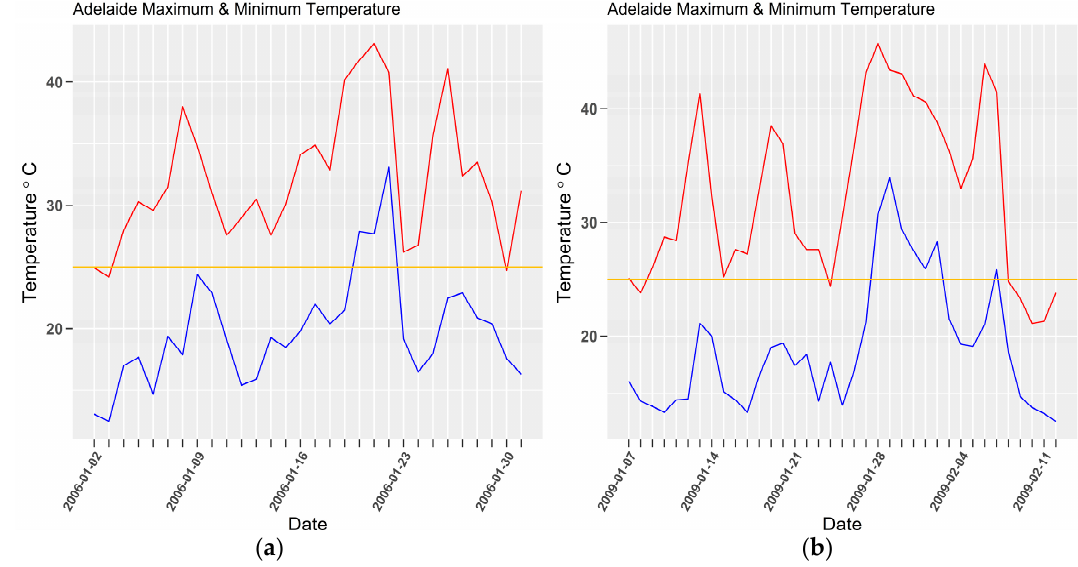
Figure A1. Daily maximum and minimum temperatures for Adelaide heatwaves in 2006 ( a ) and 2009 ( b ). 25 °C reference temperature (yellow line).